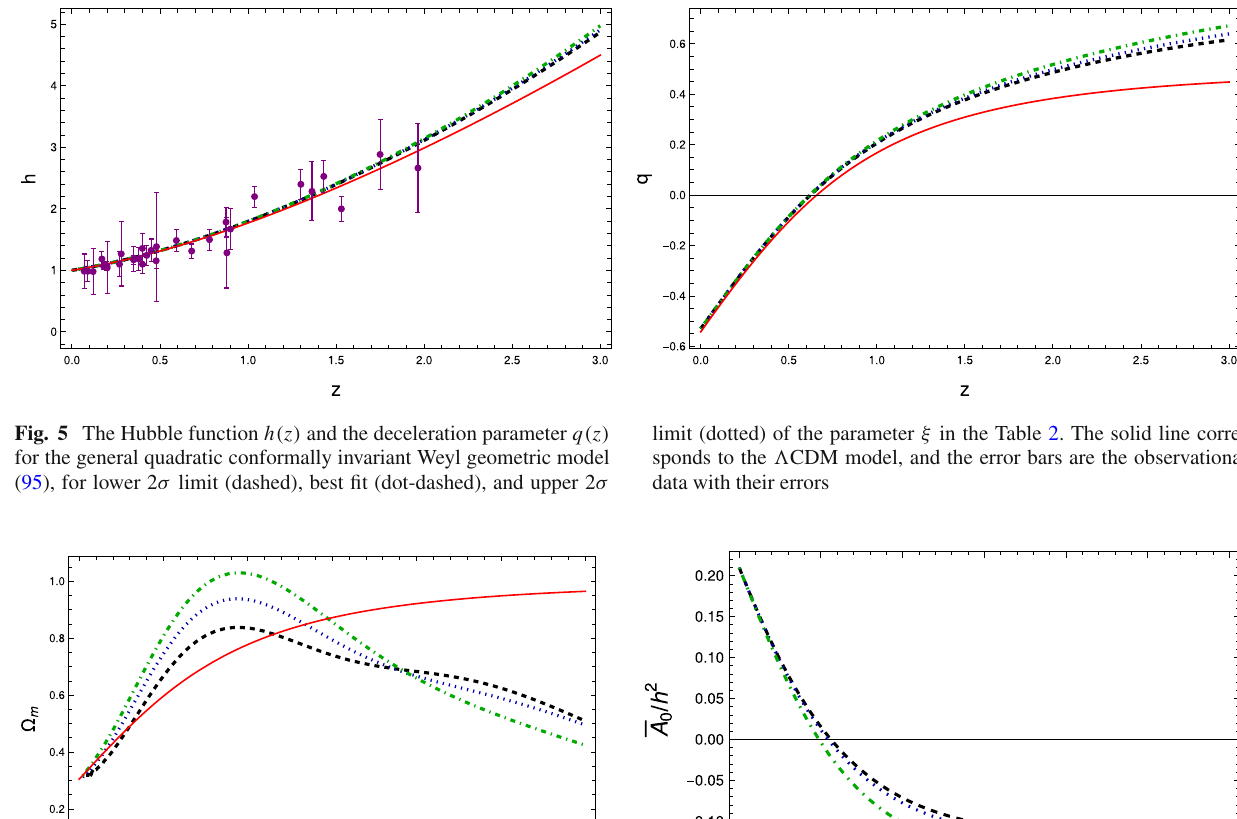
(dashed curve), best fit (dot-dashed curve), and upper 2 σ limit (dotted curve) of the parameter ξ as given in Table 2. The solid line corresponds to the (cid:2) CDM